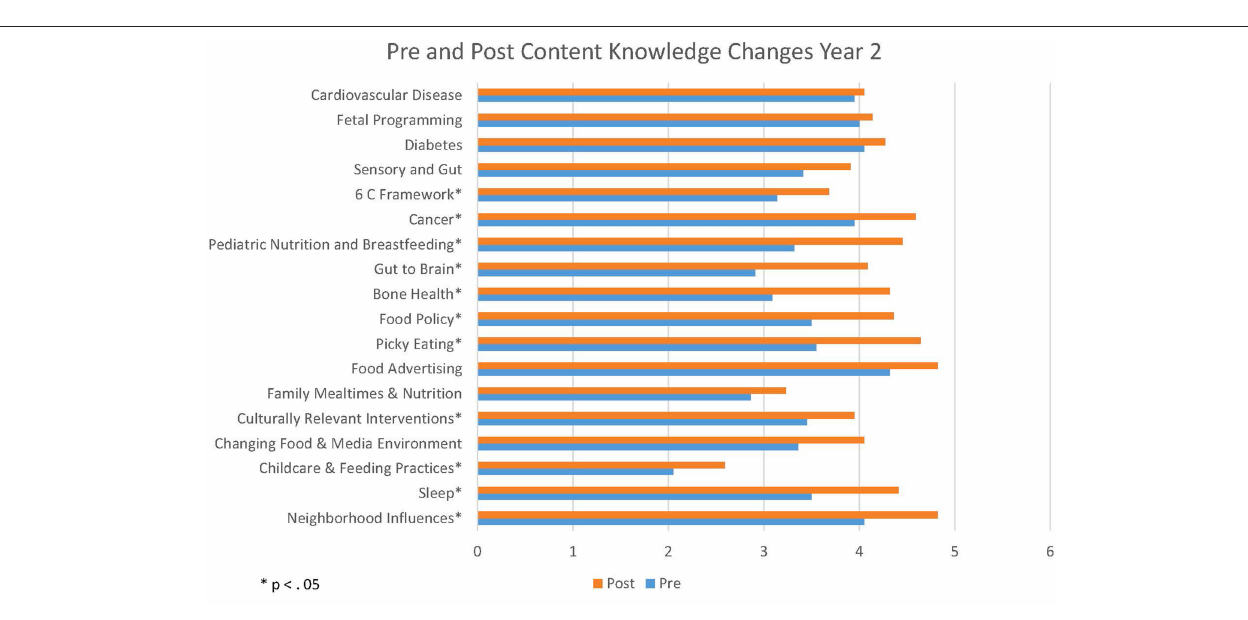
FIGURE 3 | Change in content knowledge Year 2. * Means were statistically significant between pre- and post-surveys ( p <